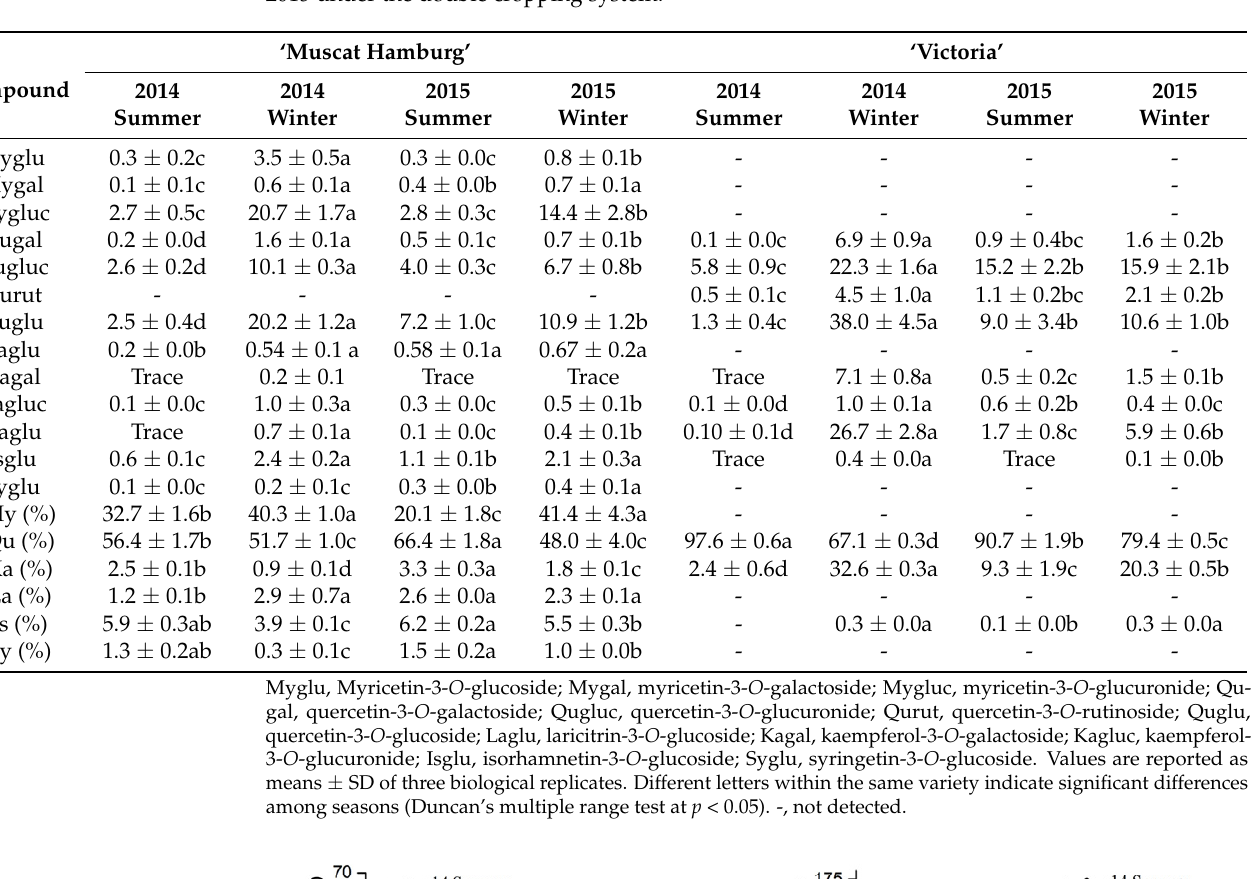
Table 3. Flavonol concentration ( mg/kg FW) in ‘Muscat Hamburg’ and ‘Victoria’ grapes in 2014 and 2015 under the double cropping system.